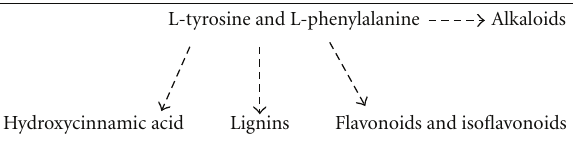
Figure 9: Secondary metabolites derived from the catabolism of L-Tyrosine and L-Phenylalanine in plants. The synthesis of secondary metabolites that are involved in plant defense occurs via the degradation of L-Tyrosine and L-Phenylalanine through the phenylpropanoid pathway.